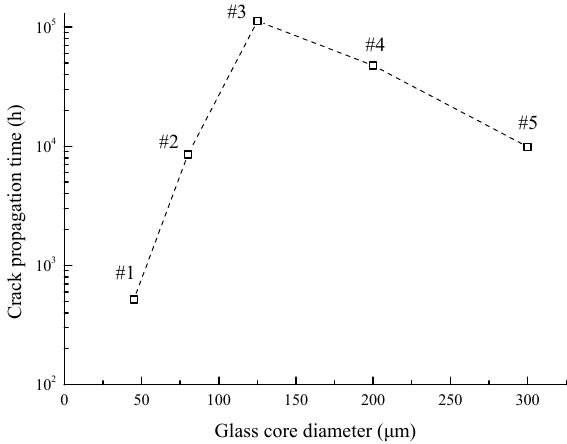
Figure 11. Crack propagation time vs. glass core diameter.